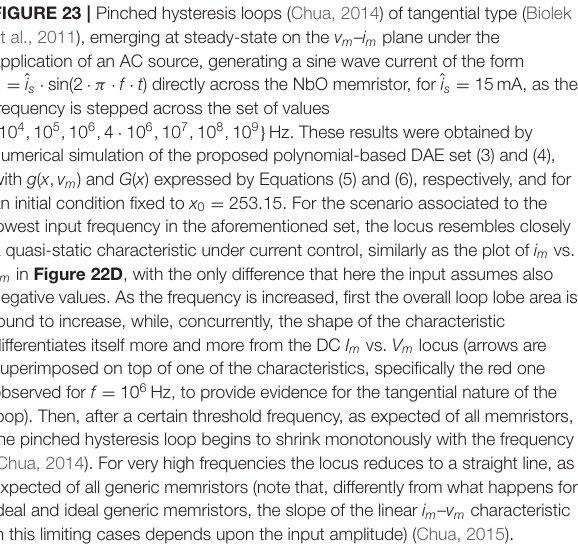
superimposed on top of one of the characteristics, specifically the red one observed for f the pinched hysteresis loop begins to shrink monotonously with the frequency ( Chua, 2014). For very high frequencies the locus reduces to a straight line, as expected of all generic memristors (note that, differently from what happens for ideal and ideal generic memristors, the slope of the linear i m – v m characteristic in this limiting cases depends upon the input amplitude) ( Chua, 2015).